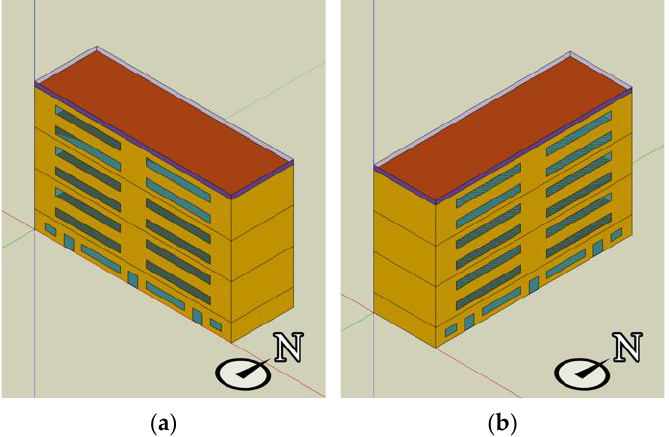
Figure 1. Axonometric view of the building model in: ( a ) north-south and ( b ) east-west orientations [32]. Table 1. Optimal WWR, varying the orientation of the building’s two main facades [58,61–63]. North-South Orientation East-West Orientation North Facade South Facade East Facade West Facade 0.37 0.27 0.33 0.34